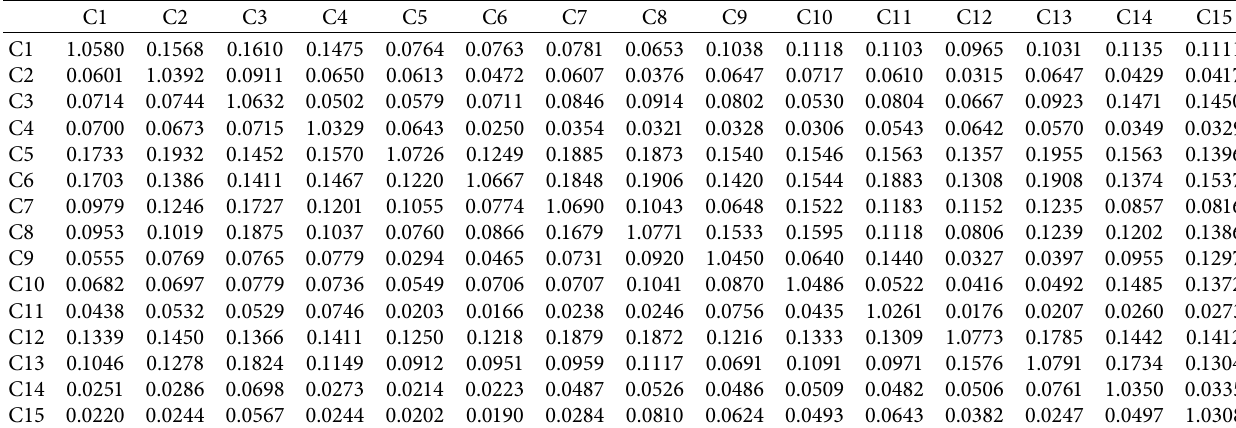
Table 6: Overall influence